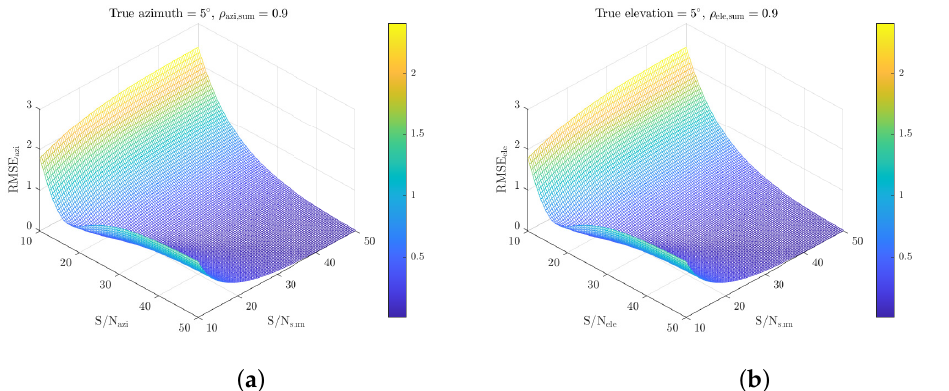
Figure 12. RMSE for difference channel SNR and sum channel SNR ( θ azi , θ ele = 5 ◦ , ρ azi,sum = 0.9).